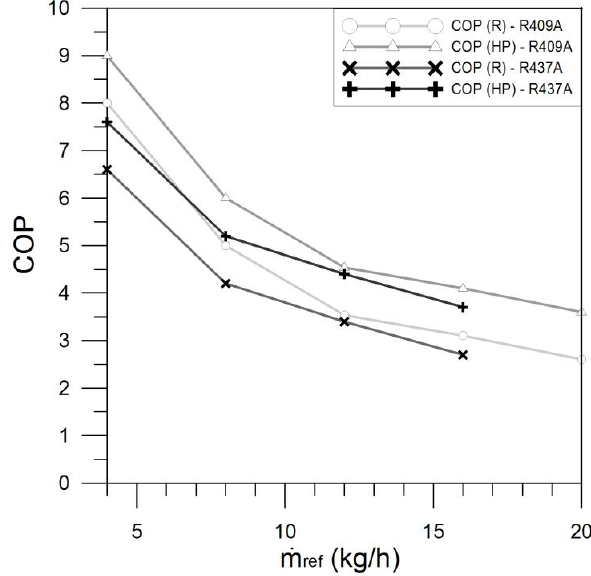
Figure 11: Effect of refrigerant flow rate on COP (Group B of